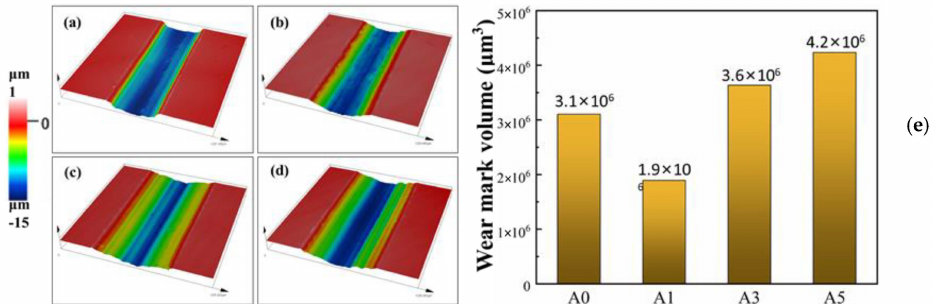
Figure 9. ( a – d ) The 3D surface morphologies of the wear marks on samples A0, A1, A3, and A5; ( e ) sample wear